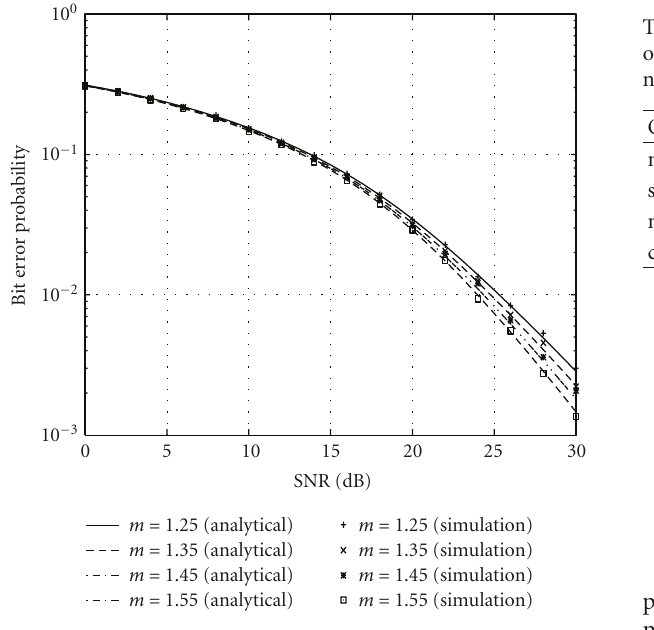
Figure 9: BEP for 16 × 32-QAM subject to Nakagami fading for di ff erent values of m , ranging from 1.25 to 1.55.